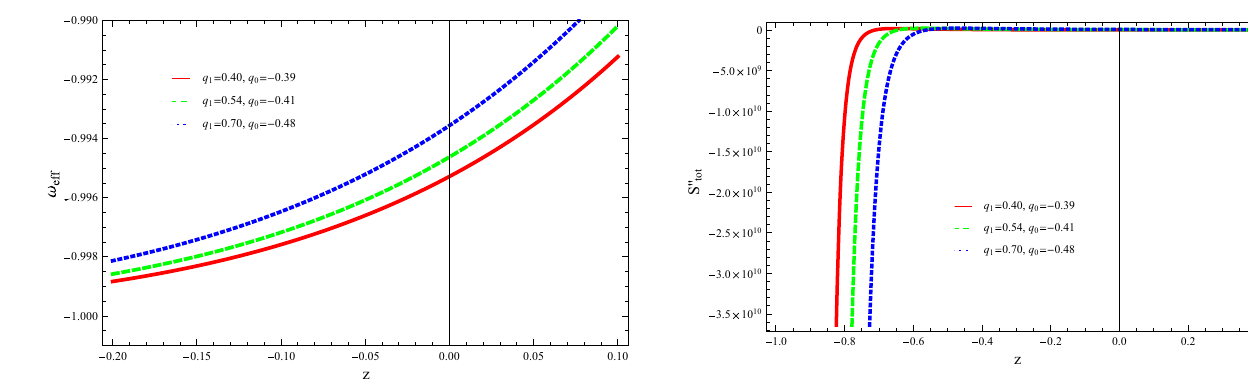
In Fig. 9 EoS parameter displays the quintessence region in early, present as well as later epoch. The right side trajecto- ries Fig. 10 increasing positively which confirms the stability condition at early, present as well as later epoch. Figure 11 demonstrate the validity of GSLT at early, present as well as later epoch as all trajectories fulfill the ≥ 0 . All trajectories (Fig. 12) shows that the condition S (cid:5) tot thermal equilibrium condition satisfies at early, present as well as later